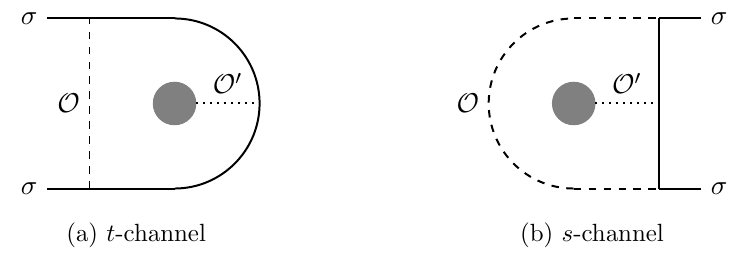
0 ) ( h ) (cid:2) a h (cid:27)(cid:27) i ( O ( h [ (cid:27)(cid:27) ] n [ (cid:27)(cid:27) ] n